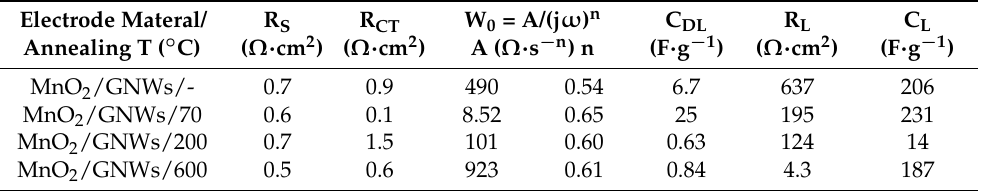
Table 1. Equivalent circuit parameters obtained from fitting the EIS data of MnO 2 /GNWs nanocomposites. Electrode Materal/